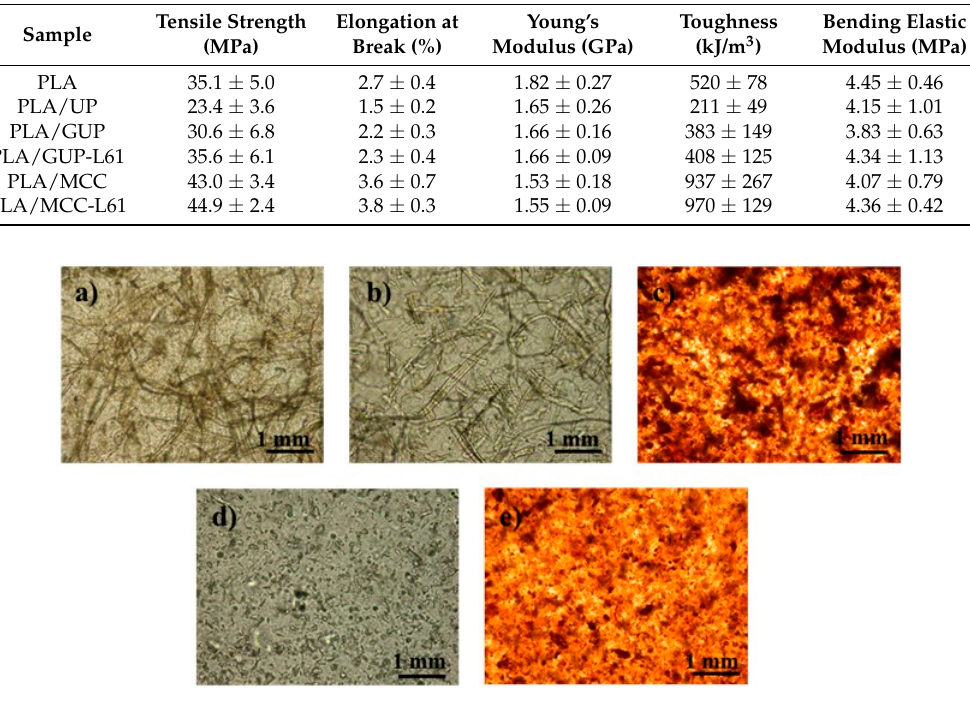
Figure 11. Optical microscopy images of the PLA/cellulose composite films: ( a ) PLA/UP; ( b ) PLA/GUP; ( c ) PLA/GUP-L61; ( d ) PLA/MCC; ( e ) PLA/MCC-L61 (see Table 1 for sample identification).